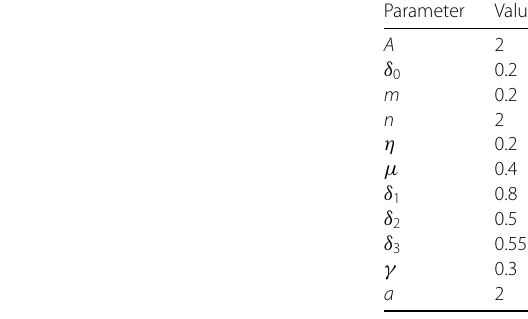
Figure 1 Time series plot of the susceptible population for R 0 = 0.571429 < 0.910714 with